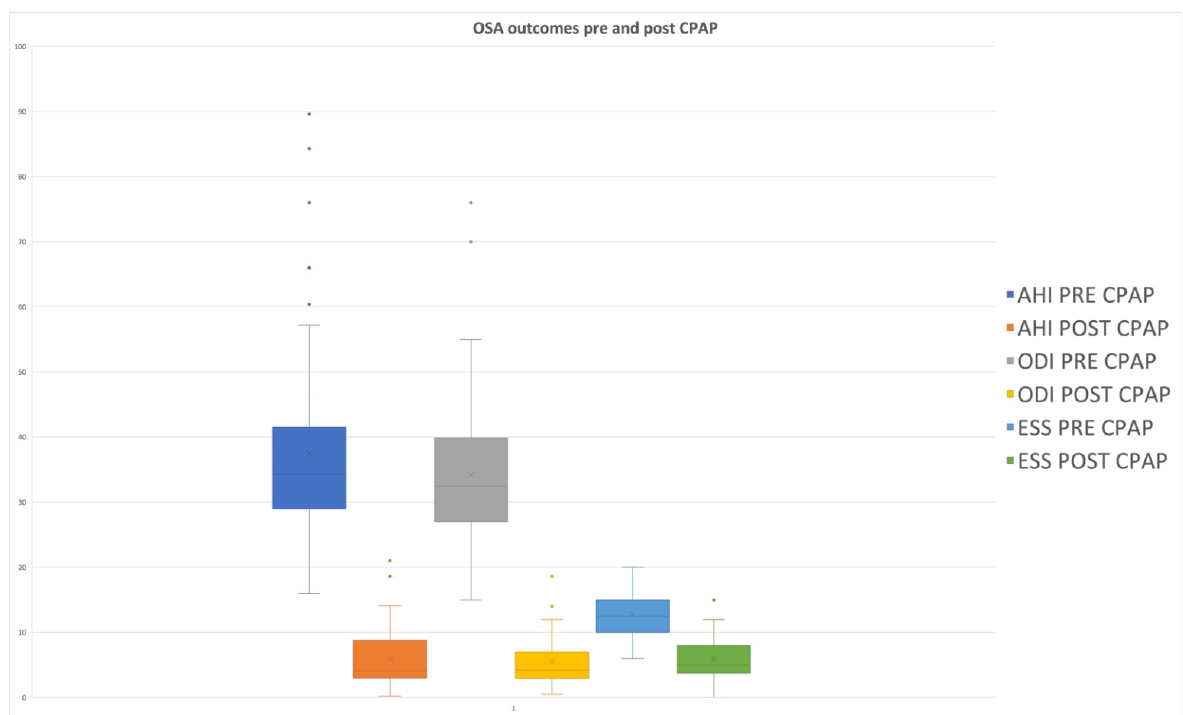
Figure 2. Box plot showing differences in OSA outcomes pre- and post-CPAP treatment. Apnea